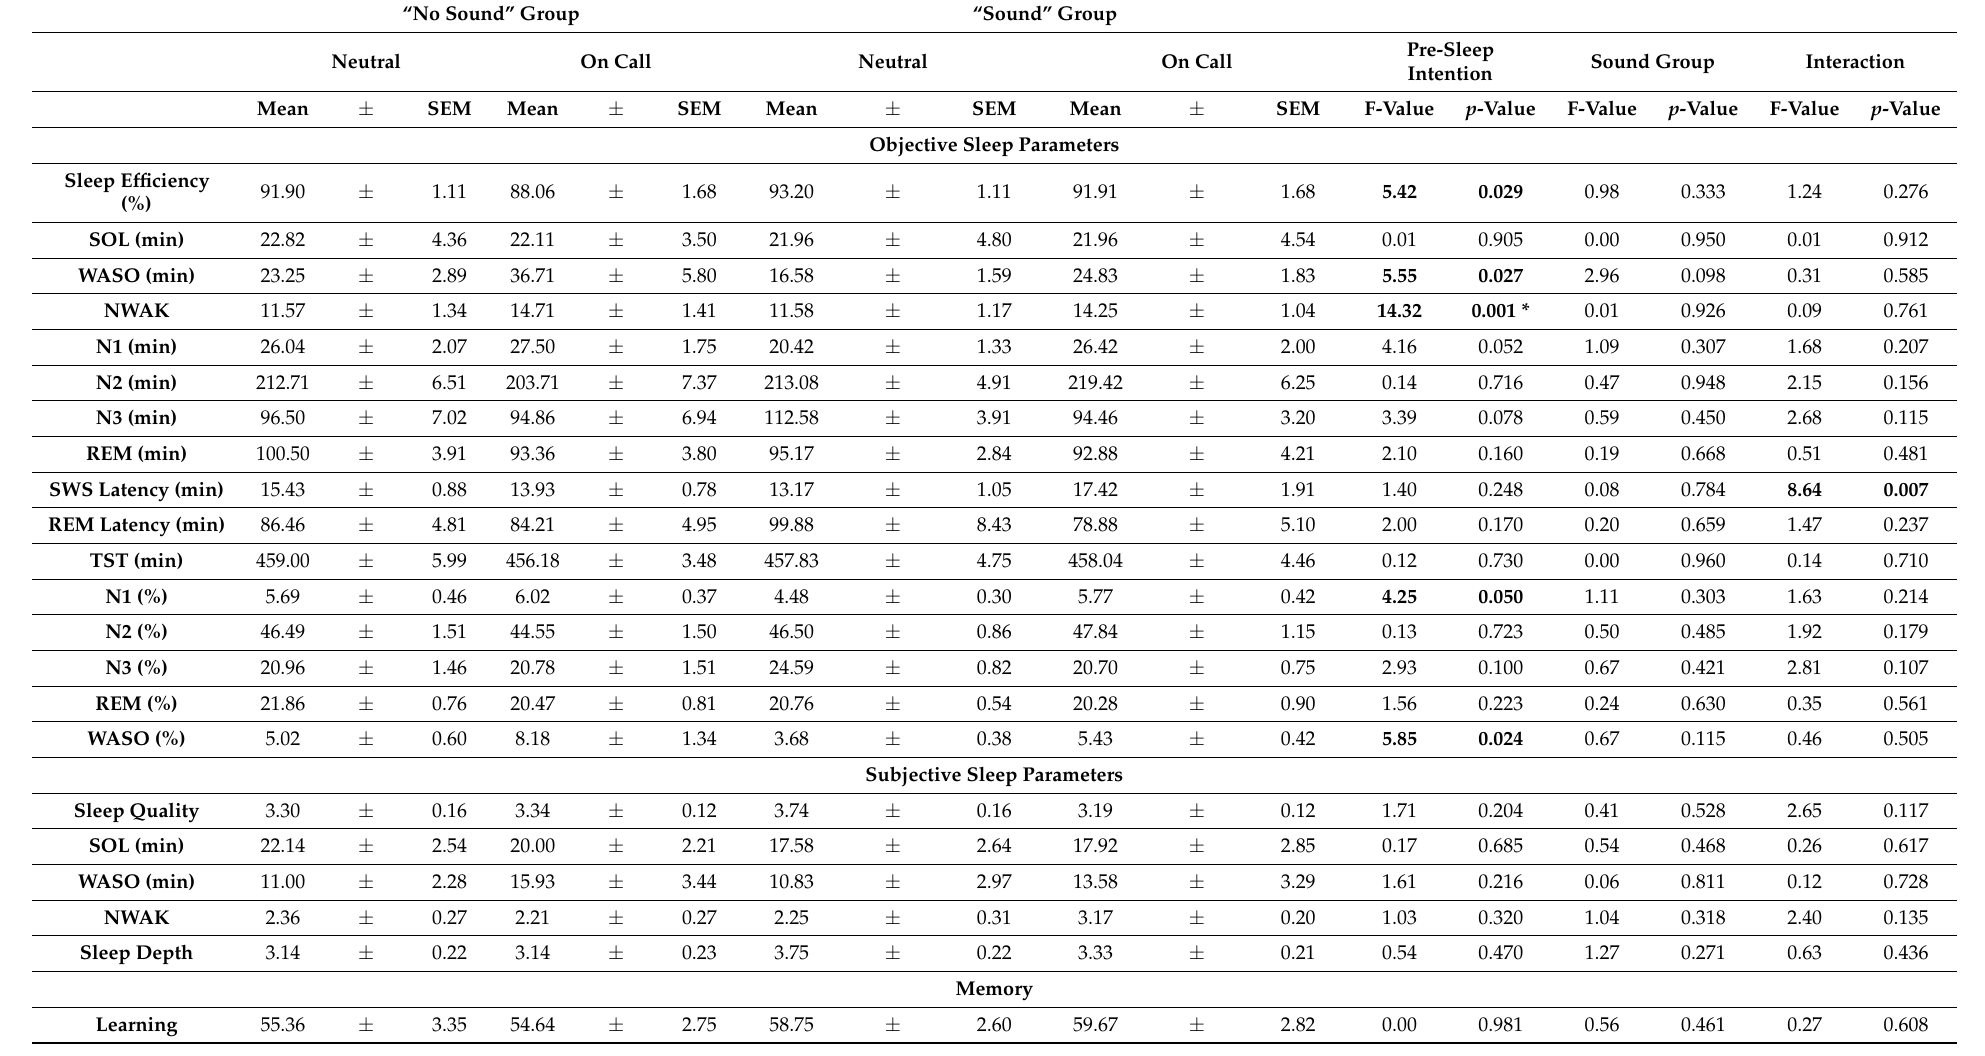
Table 1. Objective and subjective sleep